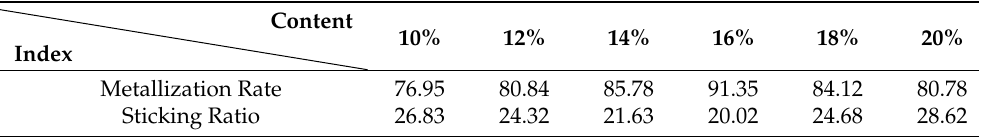
Table 9. Effect of cow dung content on metallization rate and sticking